Question: Based on the figure, does the quantity rise or fall?
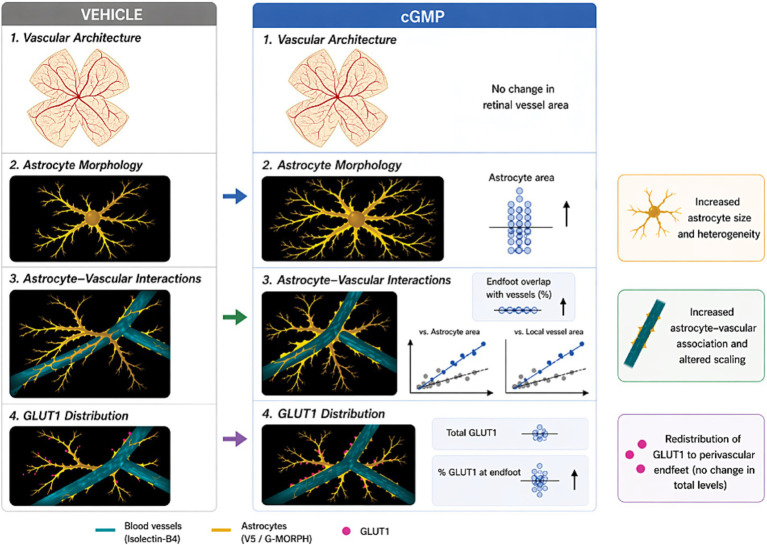
Answer: increasing